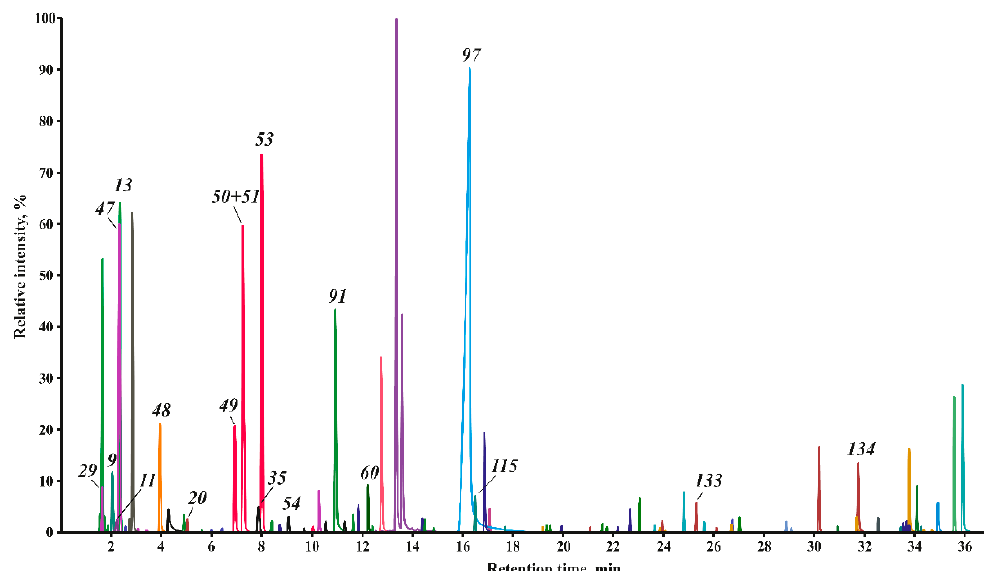
Figure 2. Reconstructed XIC chromatogram of the target analytes in air sample No. 5 (peak numbers correspond to compound numbers in the Tables).